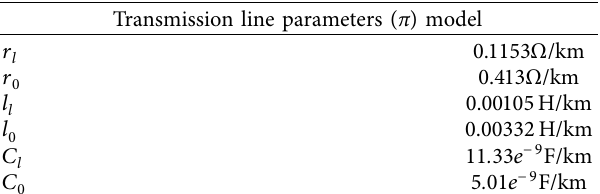
Table 8: Transmission line parameters